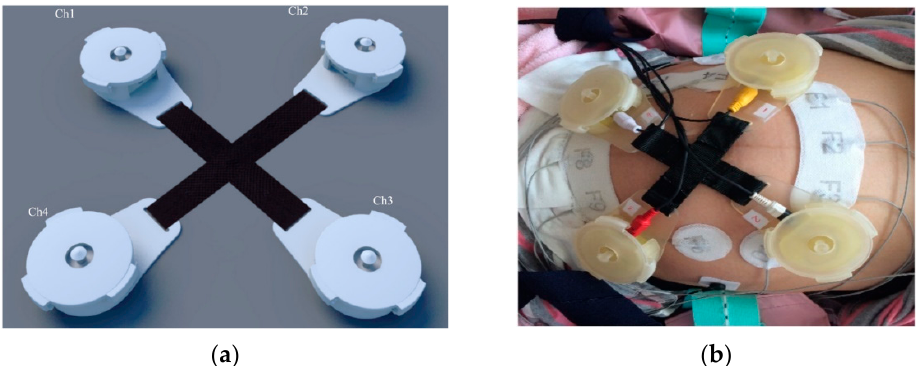
Figure 4. ( a ) A schematic diagram showing the locations of phonogram sensors. Ch1, Ch2, Ch3, and Ch4 are four phonogram sensors. ( b ) Locations of phonocardiogram sensors and fetal ECG electrodes for the cross-validation experiment [52] (Reprinted with permission from ref. [52] (2018, CC BY 4.0)).